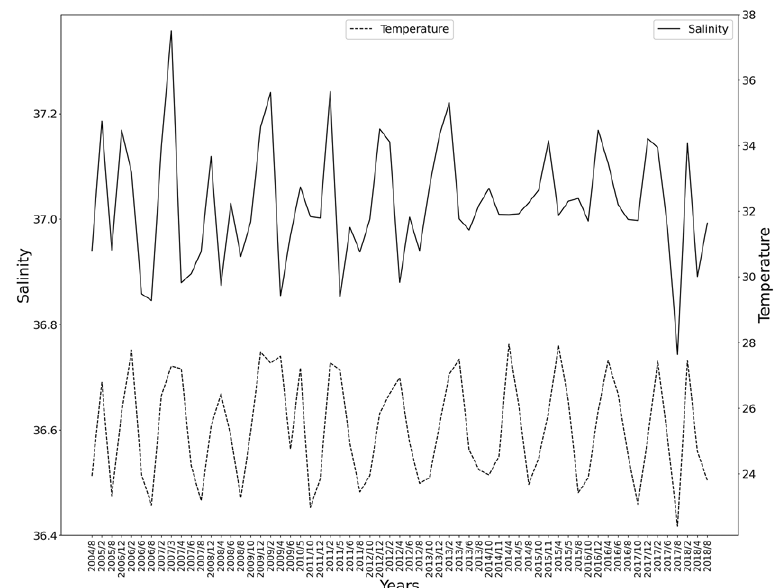
Fig. 3. – Variation in SST (°C) and salinity (psu) in the surroundings of Trindade Island from 2004 to 2018 (raw data obtained from CTD/ XBT profiles performed between the Brazilian continental shelf and Trindade Island: MOVAR-GOOS (http://www.goosbrasil.org/movar).